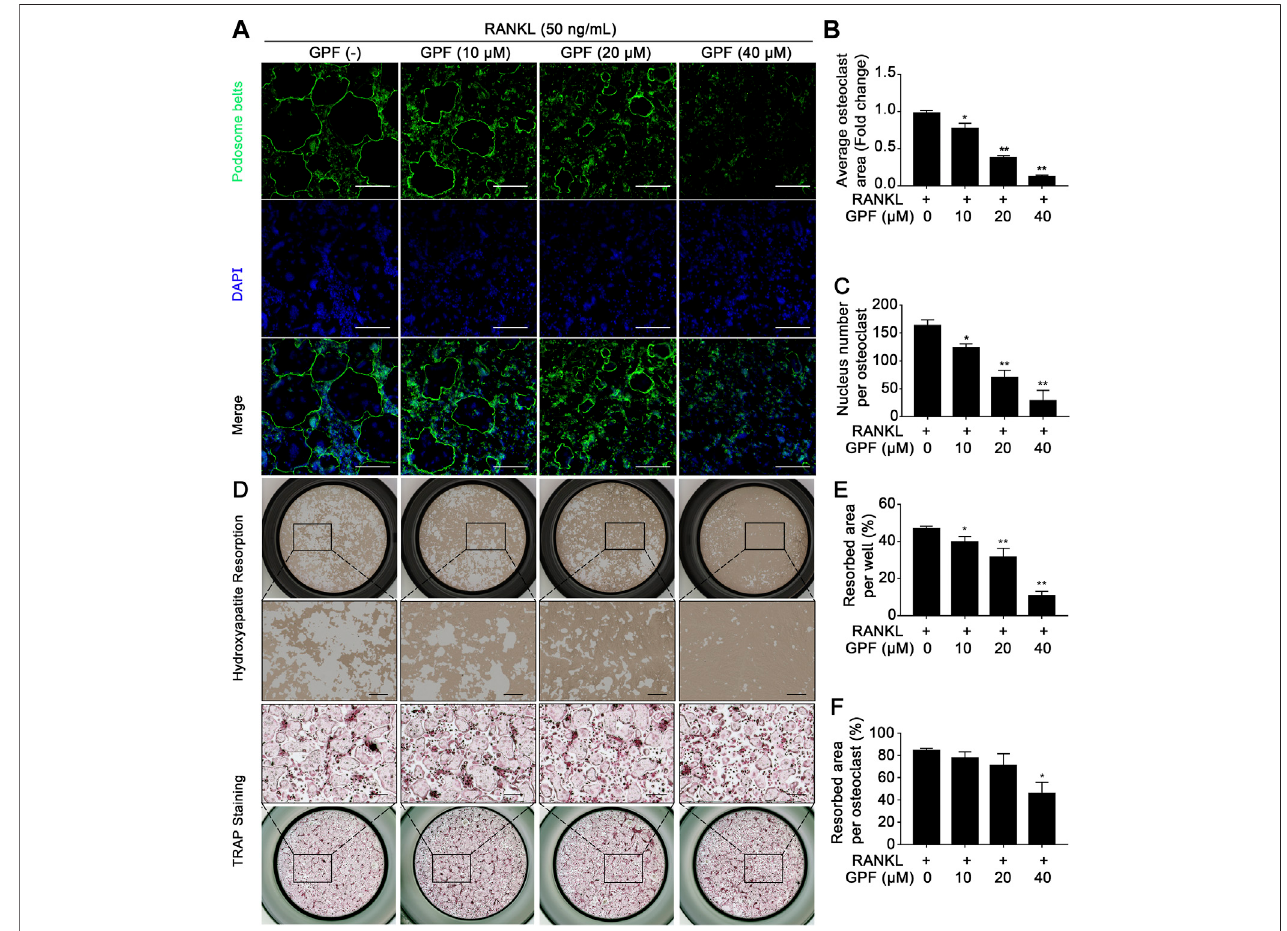
FIGURE 2 | GPF inhibits podosome belt formation and bone-resorptive function of osteoclasts. (A) Representative images showing podosome belt formation in osteoclasts treated with GPF. podosome belt (green) and nuclei (blue) staining of osteoclasts. (B,C) Quanti fi cation of average osteoclast area and the nuclei number per osteoclast ( n (cid:2) 3). (D) Representative images showing the osteoclastogenesis and hydroxyapatite resorption. Pre-osteoclast-like cells were seeded in hydroxyapatite-coated plates and treated by RANKL with or without GPF. After fi xing 1/2 wells, cells were subjected to staining to detect the TRAP activity. In the remaining 1/2 wells, cells were bleached and removed with hypochlorous acid. (E,F) Quanti fi cation analyses of resorbed area per well and resorbed area per osteoclast ( n (cid:2) 3). All bar graphs are presented as mean ± SD. * p < 0.05, ** p < 0.01 compared with control group (without GPF treatment). One-way ANOVA. Scale bar (cid:2) 200